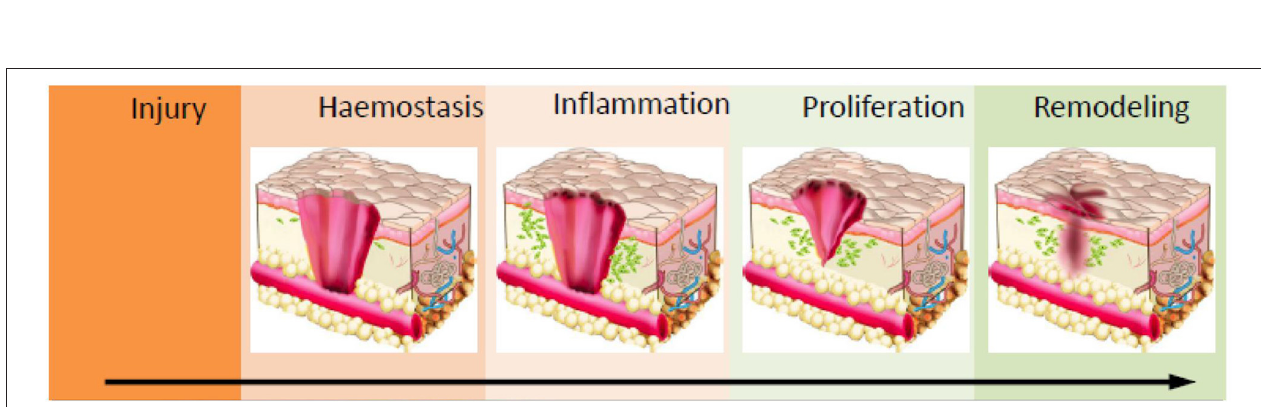
FIGURE 1 | Schematic of different layers of skin and its appendages. Reprinted with permission from Mohammadi et al. (2016). Copyright 2018, John Wiley & Sons.